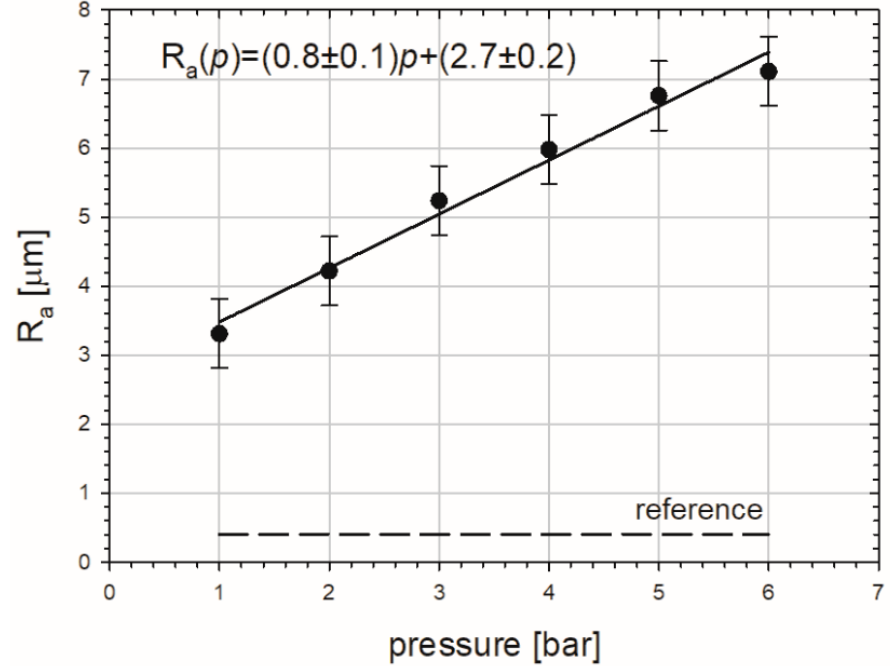
Figure 4. Mean roughness of the sandblasted copper specimens in dependency on the blasting pressure. The solid black line represents the linear least-squares fit to the obtained points and the results are given above, where p is the pressure in bar. The dashed one represents the value of R a for the reference sample.